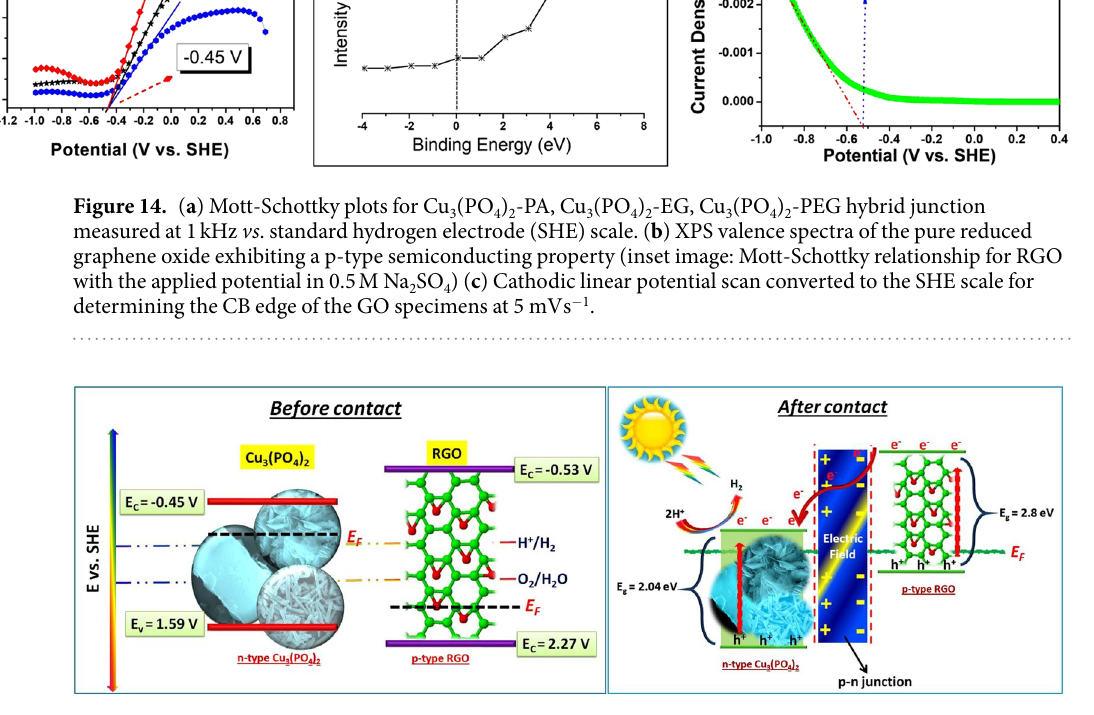
Figure 15. The band alignement of the catalysts before contact (left) and after contact (right) with p-n